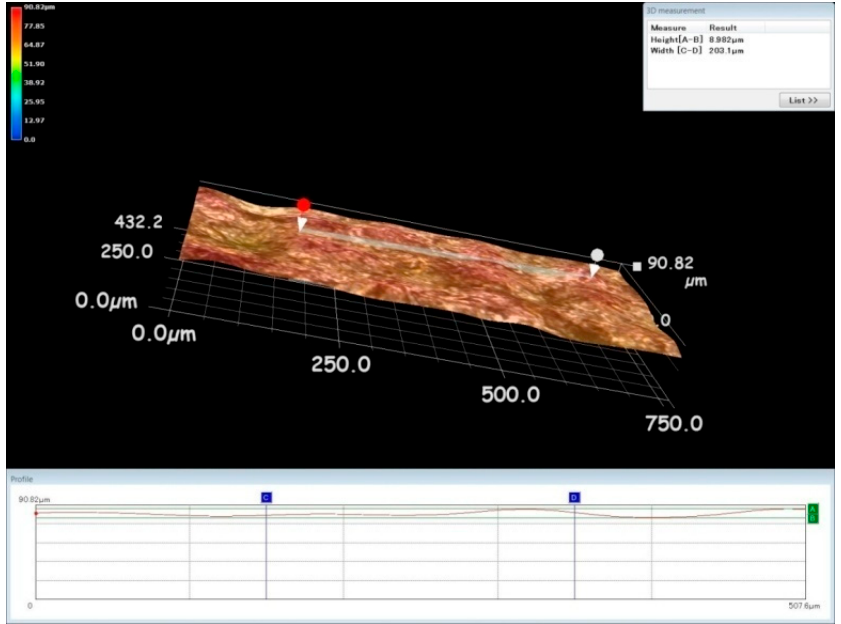
Figure 7. 3D surface analysis of machined specimen in WEDM process.